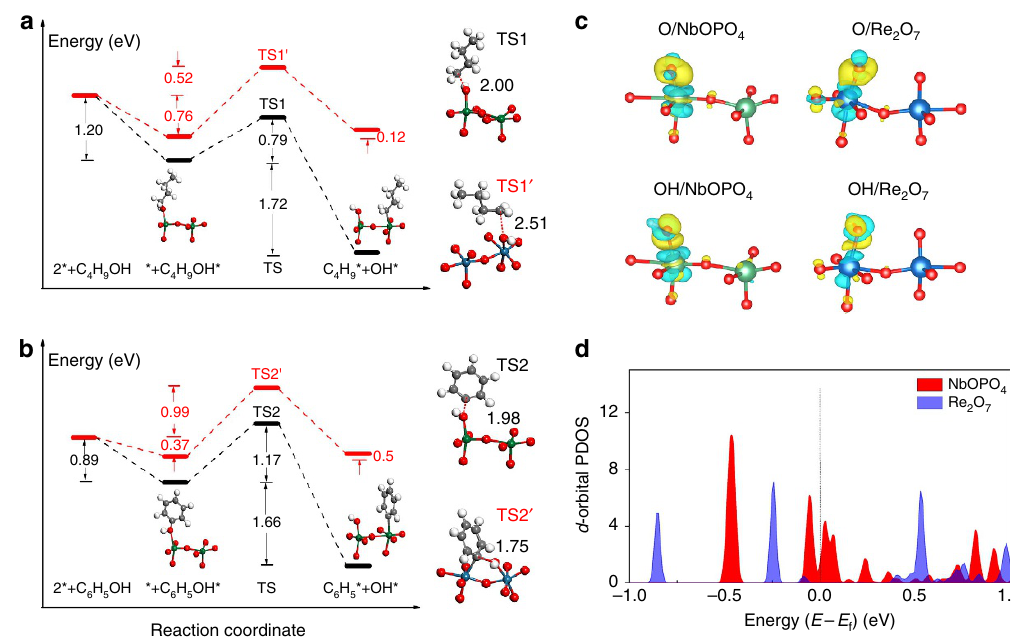
Figure 5 | Calculated results of computational studies. ( a , b ) Calculated energy profiles of C–O bond cleavage of C 4 H 9 OH and C 6 H 5 OH, respectively. Black and red lines indicate NbOPO 4 (100) and Re 2 O 7 (010), respectively. The structures of the initial and final states on NbOPO 4 (100) are shown, whereas the transition states involving C–O bond cleavage of C 4 H 9 OH and C 6 H 5 OH are depicted in TS1, TS1 0 ,TS2 and TS2 0 , with the elongated C–O bond lengths shown. Emerald balls represent Nb atoms, dark blue for Re, white for H, grey for C and red for O. ( c ) The isosurfaces of charge density difference for O and OH adsorption on NbOPO 4 (100) and Re 2 O 7 (010) surfaces. For clarity, only the local active sites are shown. The regions depicted in yellow indicate charge accumulation and light blue for charge depletion. Emerald balls represent Nb atoms, dark blue for Re, white for H and red for O. ( d ) The d -orbital projected density of states for the surface Nb 5c and Re 5c atoms, demonstrating their relative energies, in which the energy is aligned to the Fermi level ( E F